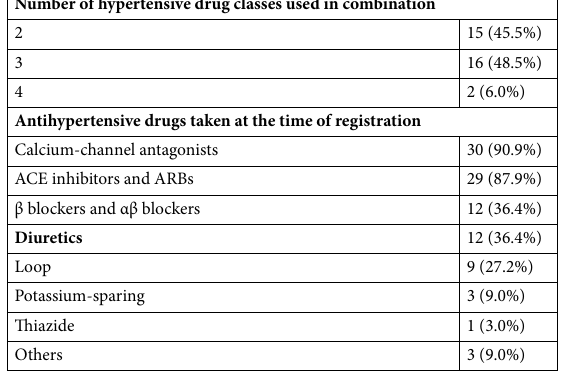
Table 2. Prescribed antihypertensive drugs . Data are expressed as number of patients (percent). ACE angiotensin converting enzyme, ARB angiotensin receptor blocker.